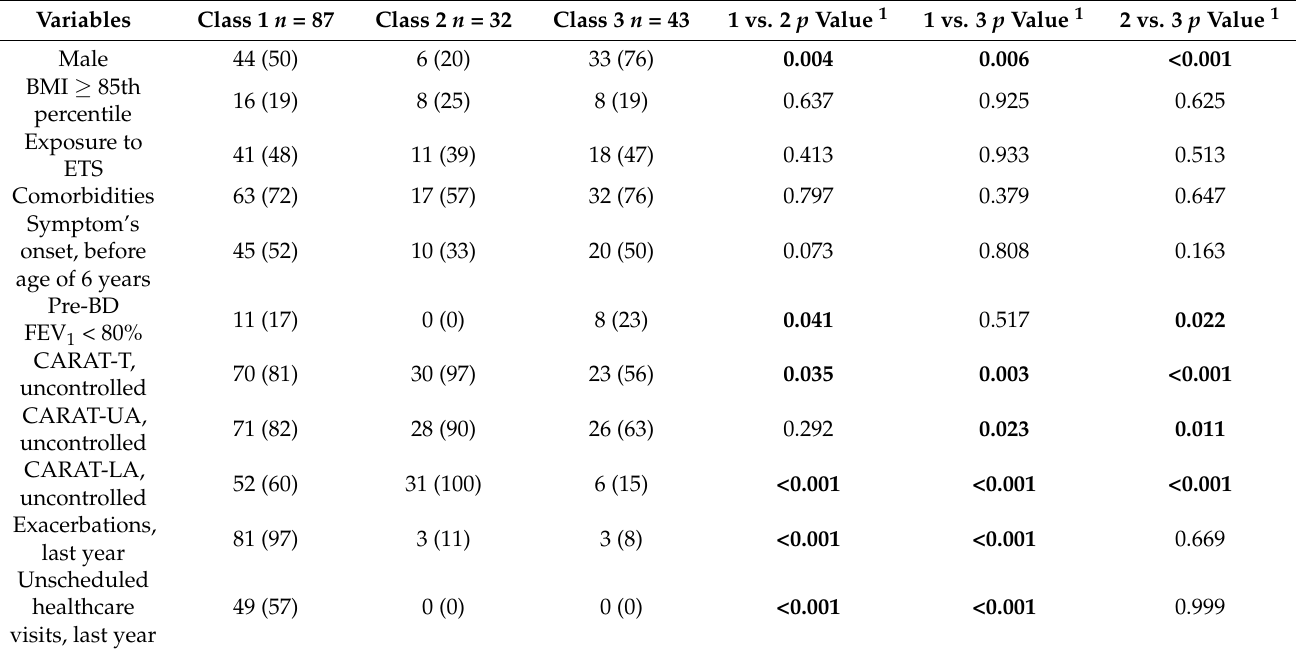
Table 2. Results of latent class analysis at the time of enrollment